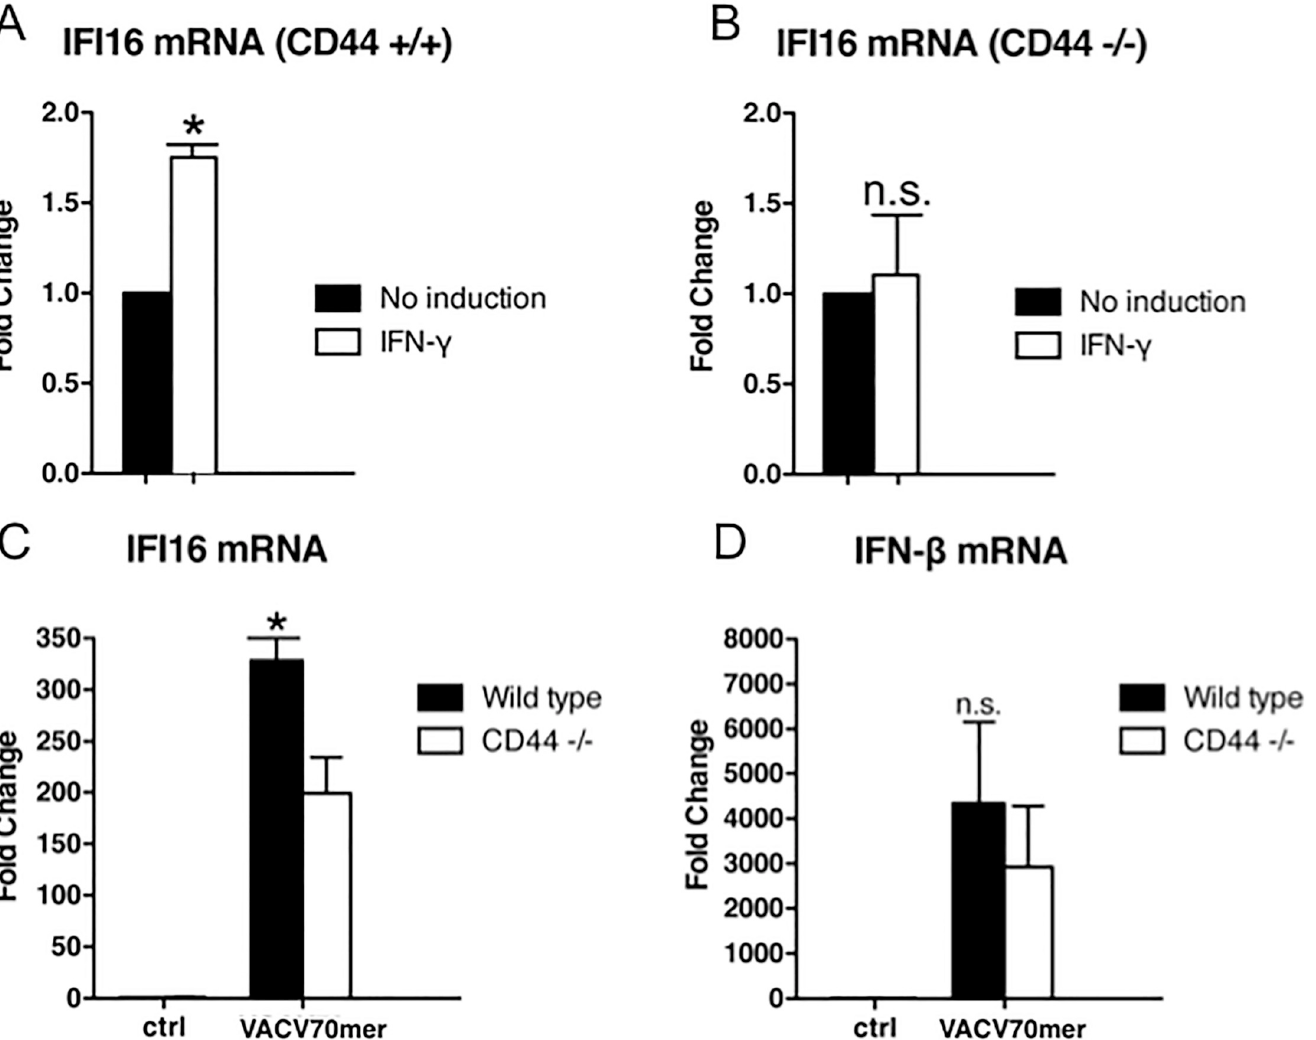
Fig 6. Impaired induction of IFI16 expression in cd44 -/- bone marrow-derived macrophages. Bone marrow-derived macrophages (BMDMs) from wild type and cd44 -/- mice were differentiated as described in Materials and Methods. Subsequently, the macrophages were serum-starved in macrophage medium w/o heat- inactivated FBS for 24 h and stimulated with 10 ng/ml IFN- γ for 6 h (A and B) or transfected with the VACV70mer oligo (C and D). RNA was determined as in Fig 4. Experiments were done in triplicates. For statistics see Materials and